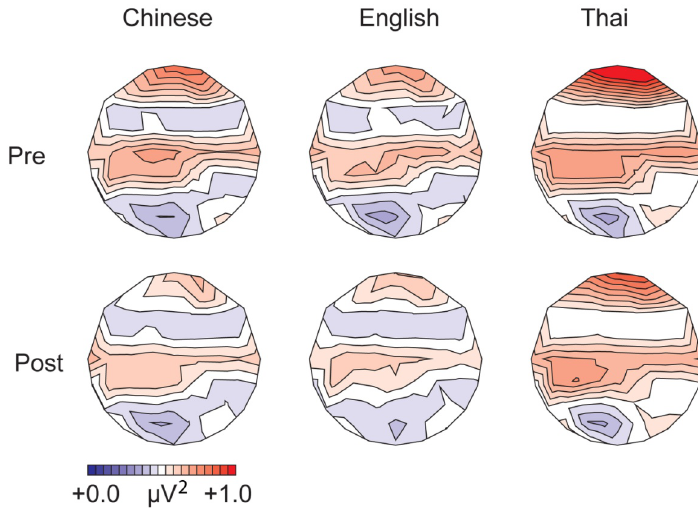
three language groups, before ( pre , upper row) and after training ( post , bottom row), artifact of the interpolation.